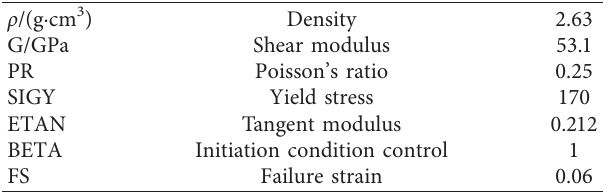
Figure 4: Elastoplastic behavior of follow-up strengthening and isotropic strengthening. Table 4: Material parameters of the reinforced concrete lighthouse model.